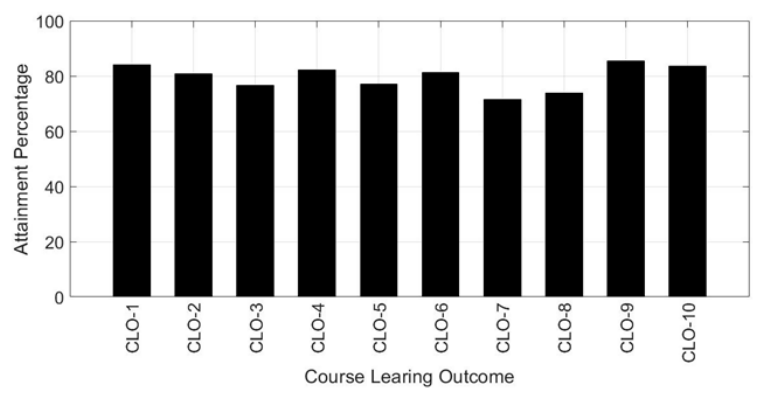
Figure 3. Attainment percentage of the